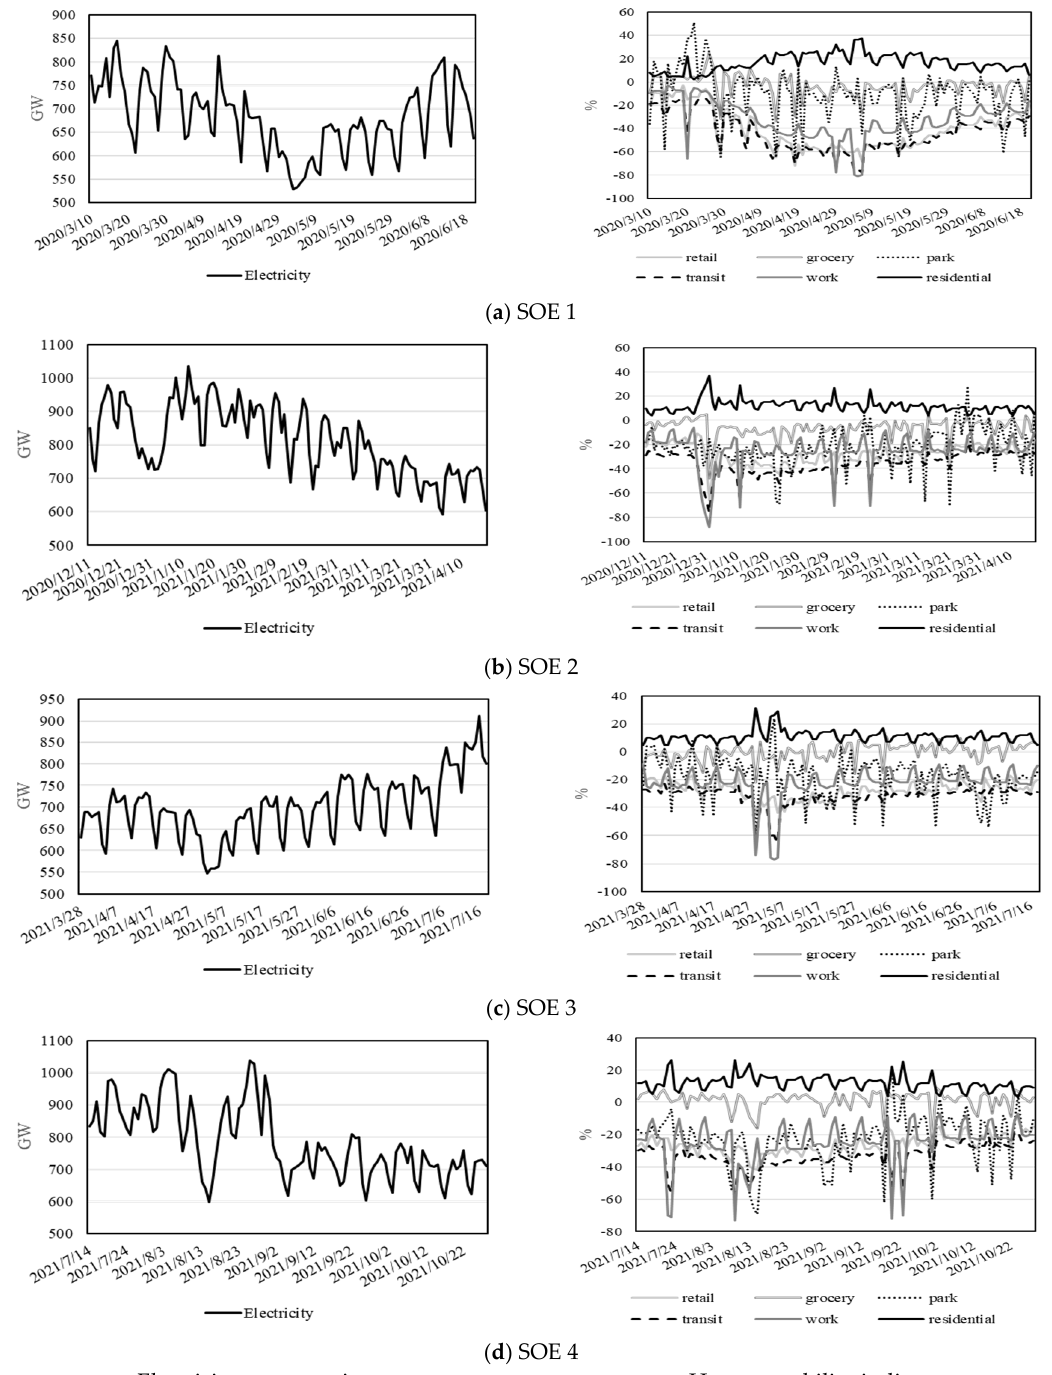
Figure 2. Electricity consumption and human-mobility